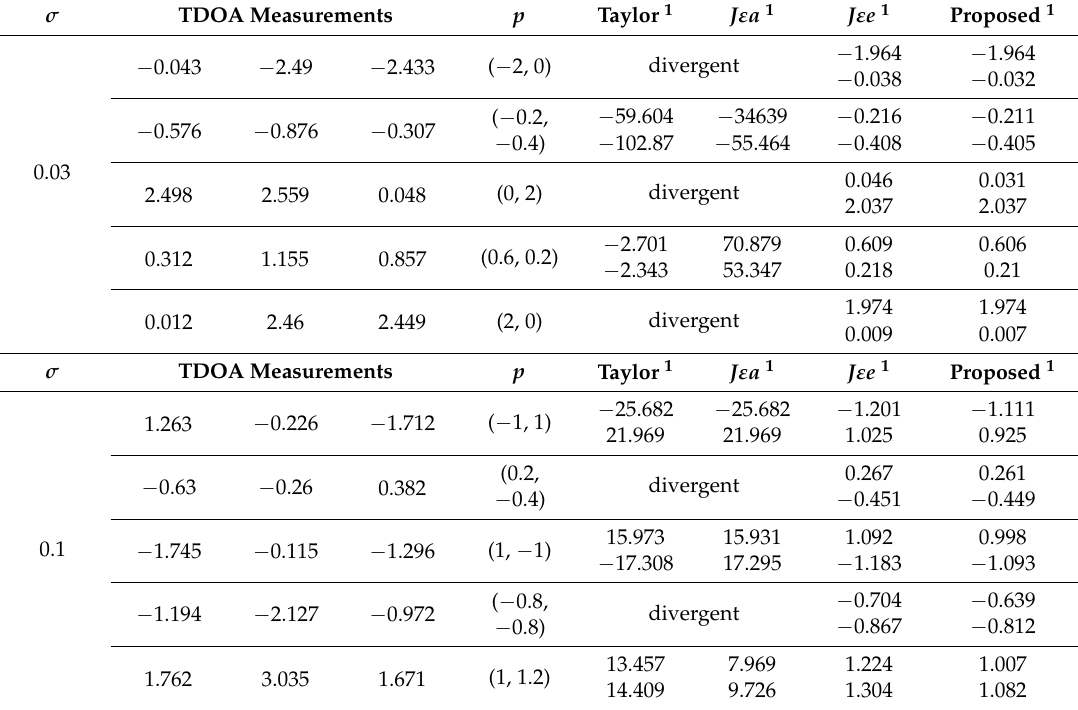
Table 1. The condition records when the localization is the wrong convergent. Unit: m.